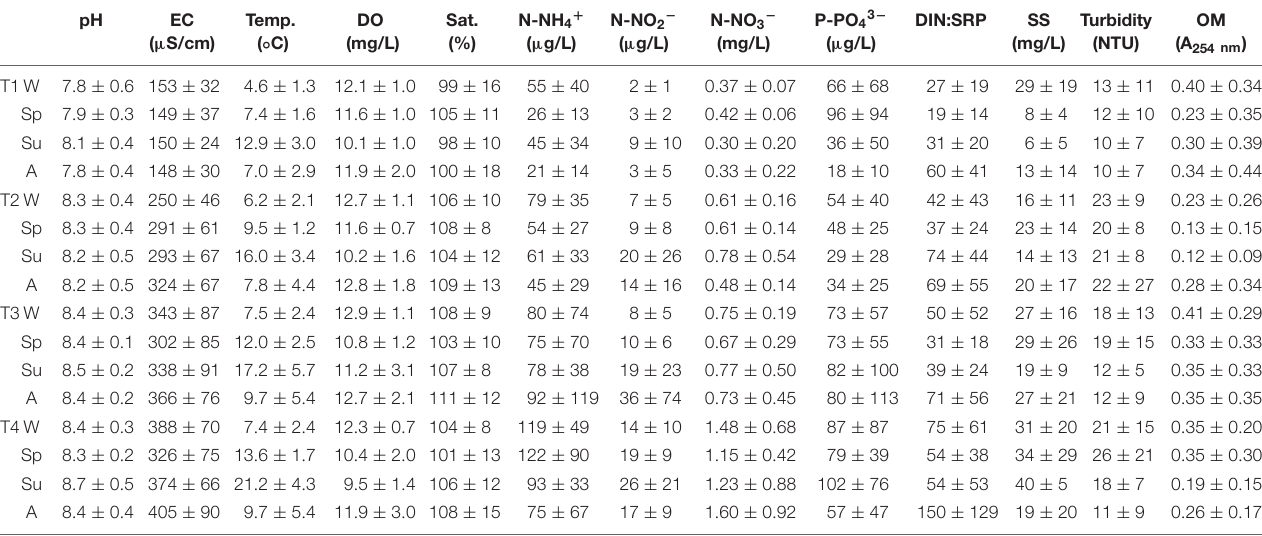
FIGURE 2 | Mean value and standard deviation of geosmin concentration in water for different sampling sites (T1, T2, T3, and T4) in upper part of Ter River basin (NE Catalonia, Spain) at each sampling day. TABLE 1 | Mean value and standard deviation of physicochemical variables evaluated for different sampling sites (T1–T4) in upper Ter River basin (NE Catalonia, Spain) in 2019: in winter (W), spring (Sp), summer (Su), and autumn